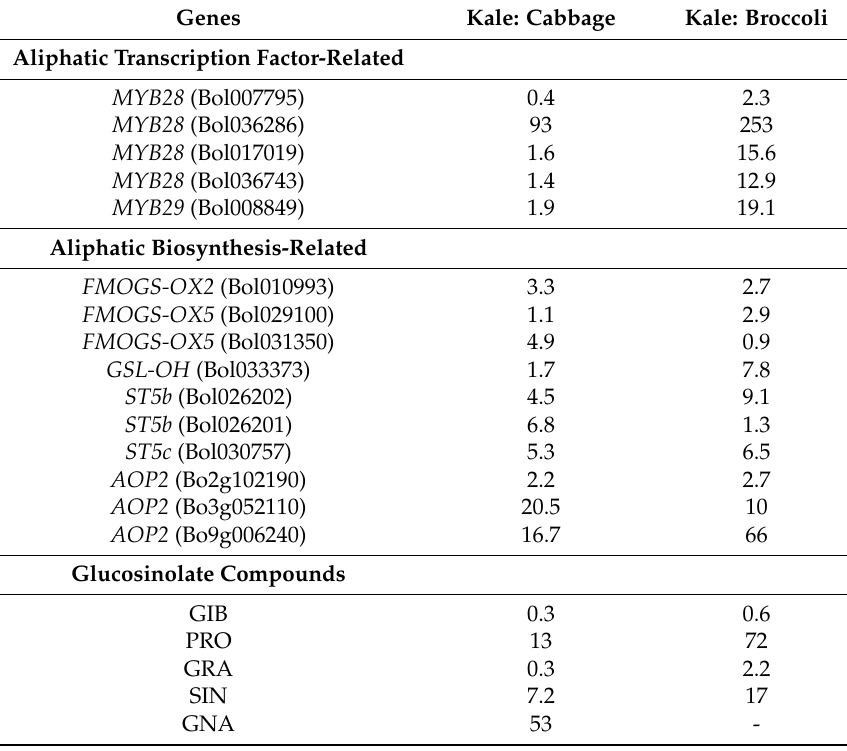
Table 3. Fold increase in relative expression of aliphatic glucosinolate transcription factor and biosynthesis genes and glucosinolate contents in kale leaves compared to cabbage and broccoli leaves for the control plants. Fold increase was calculated based on mean values obtained from three biological replicates. Genes Kale: Cabbage Kale: Broccoli Aliphatic Transcription Factor-Related MYB28 (Bol007795) 0.4